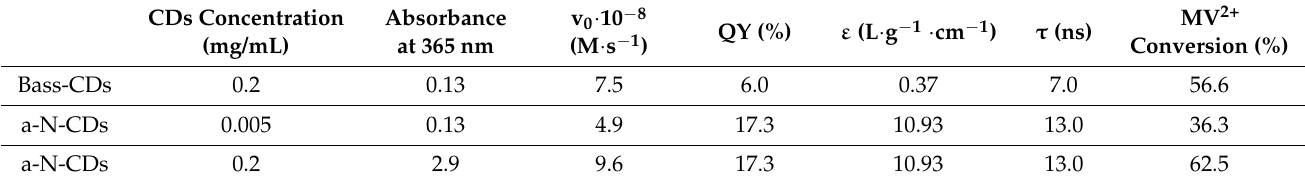
Table 3. Initial photoreduction rate (v 0 ), Quantum Yield (QY), mass absorption coefficient ( ε ), average lifetime ( τ ), and MV 2+ conversion of the synthesized